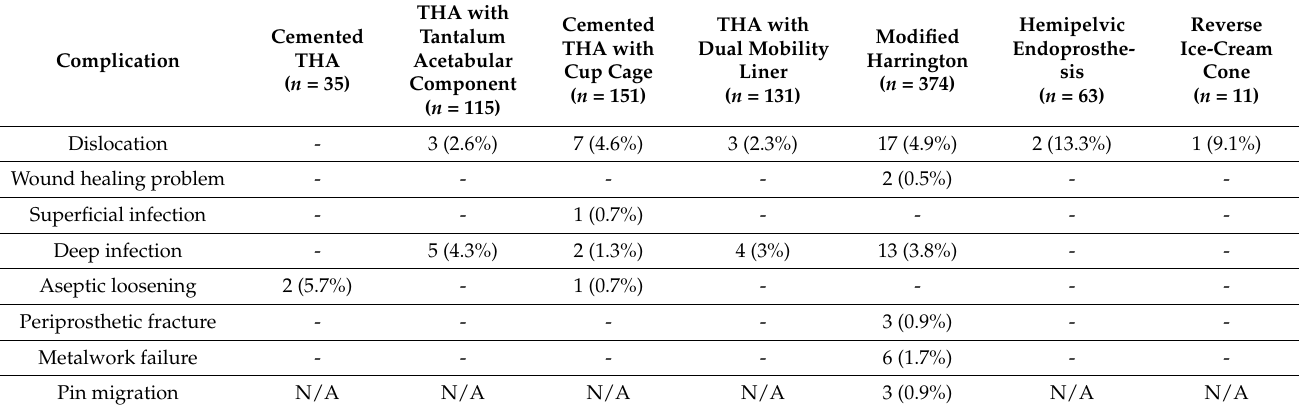
Table 2. Complications, n